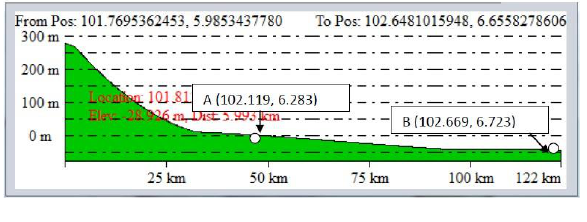
Figure 15. Slope of Geting